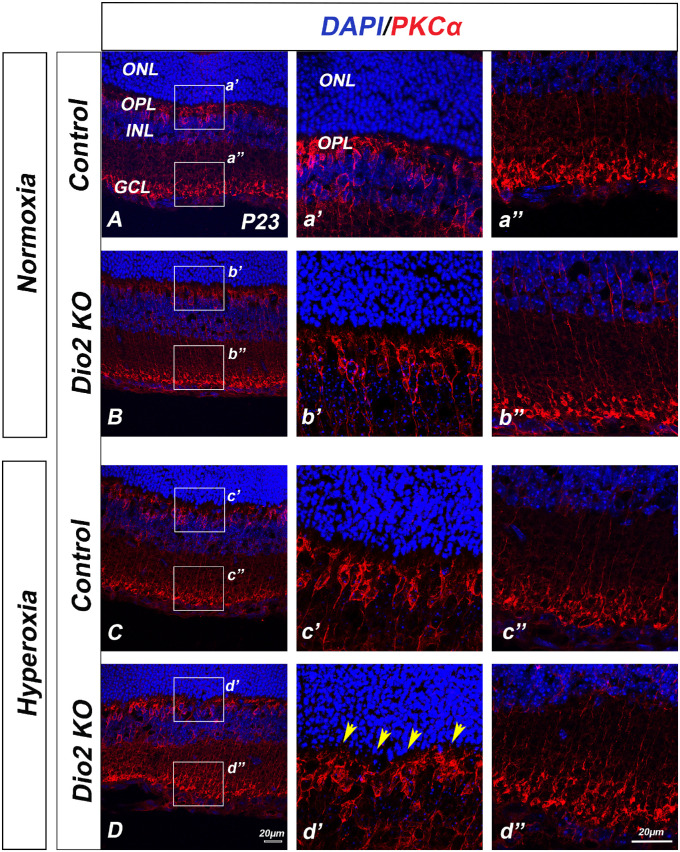
Morphological defects in Rod bipolar dendrites in the Dio2 KO hyperoxia. Immunostaining of rod bipolar cells (RBC) in P23 mouse retinal sections. (A–D) RBCs are stained with anti- PKCα in red and DAPI in blue. Magnified images of the indicated regions (white square) from controls (a’ & a”, c’ & c”) and Dio2 KO (b’ & b”, d’ & d”) under normoxia (A–b”) and hyperoxia (C–d”) conditions. (a’, b’, c’, d’) Represent the rod bipolar dendritic processes that extend into the OPL whereas (a”, b”, c”, d”) indicate the PKCα staining of RBC toward GCL layer. Controls are Dio2+/−. Yellow arrow heads indicating the dendrites crossing the OPL and reaching ONL (n = 3). GCL, ganglion cell layer; OPL, outer plexiform layer.